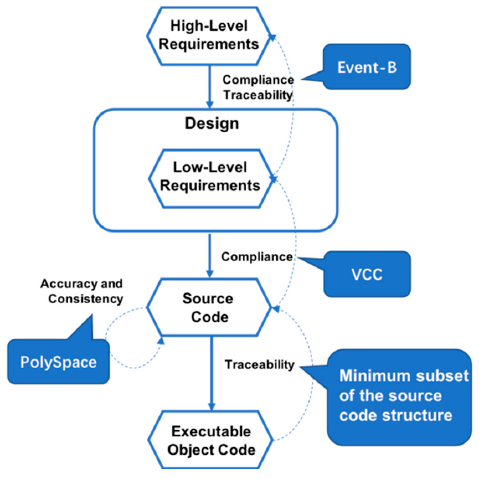
Figure 4. Verification process of ADC Software.